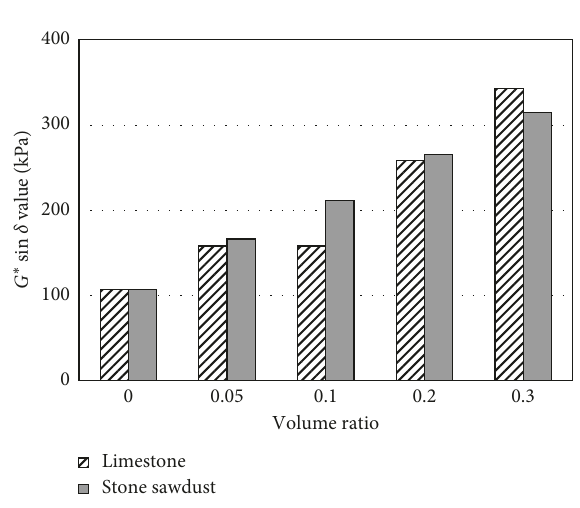
Figure 5: Fatigue behavior at 30 °